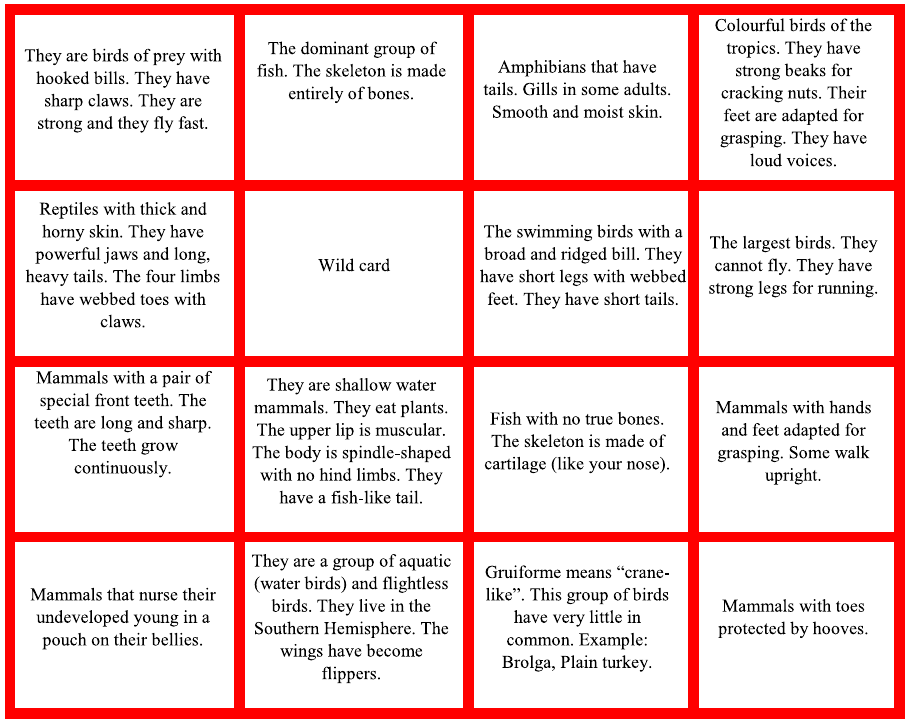
Fig. 6. Bingo Second Series: bingo card orders of the